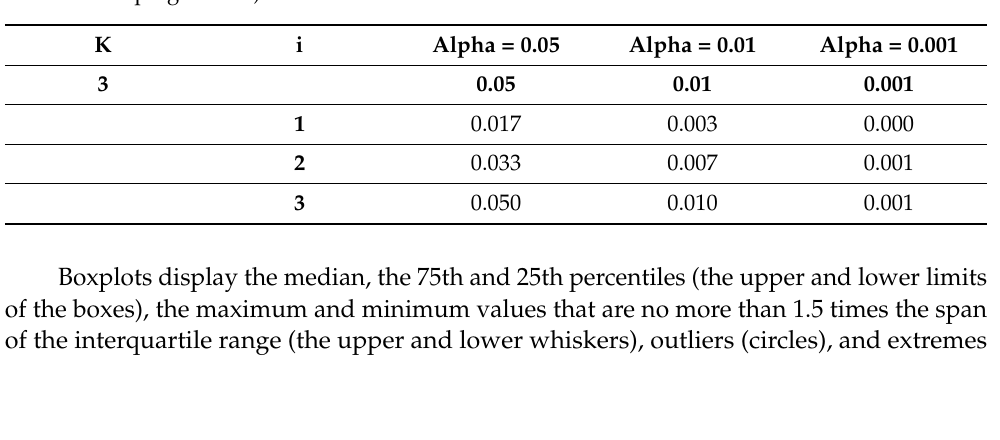
Table 7. Benjamini–Hochberg correction for multiple comparisons: comparison of microRNA gene expression between GDM and normal term pregnancies with respect to the treatment strategies (GDM pregnancies managed by diet only vs. GDM pregnancies managed by diet and therapy vs. normal term